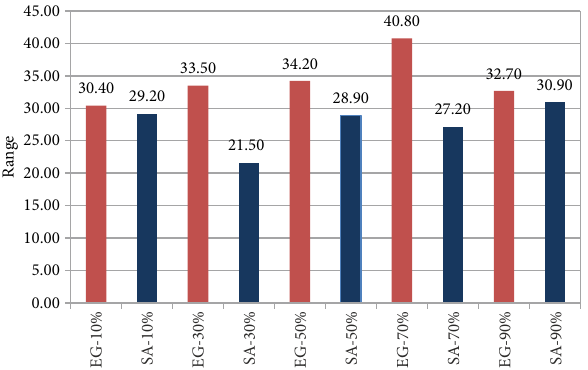
Figure 4. The range of lean effect at various implementation